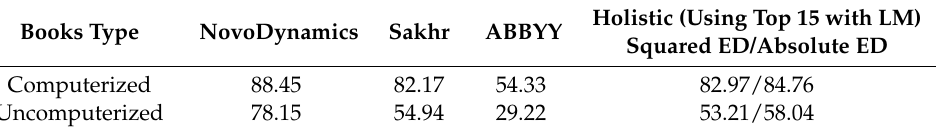
Table 5. Recognition rate (percent) of recent computerized and uncomputerized books. ED stands for Euclidean distance.